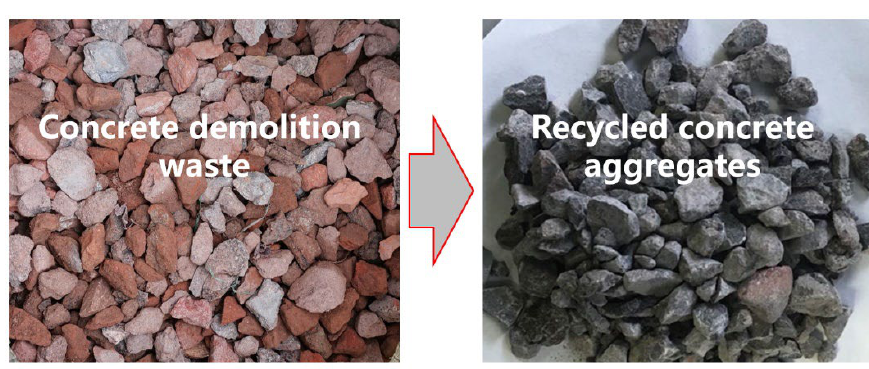
Figure 1. The recycled concrete aggregates were selected from the concrete demolition waste. Table 1. Basic properties of the recycled concrete aggregates.